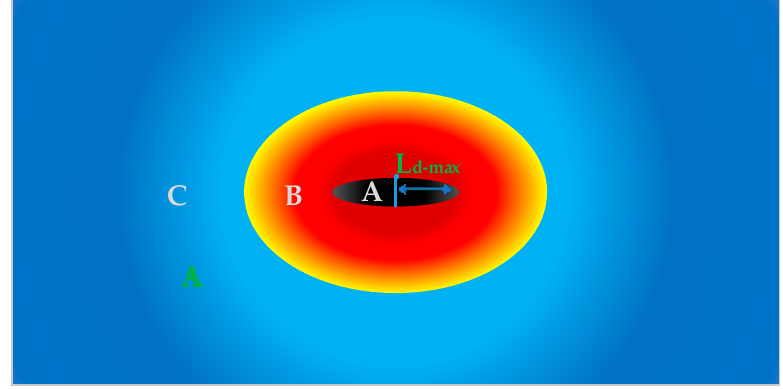
Figure 7. Schematic diagram of result evaluation.